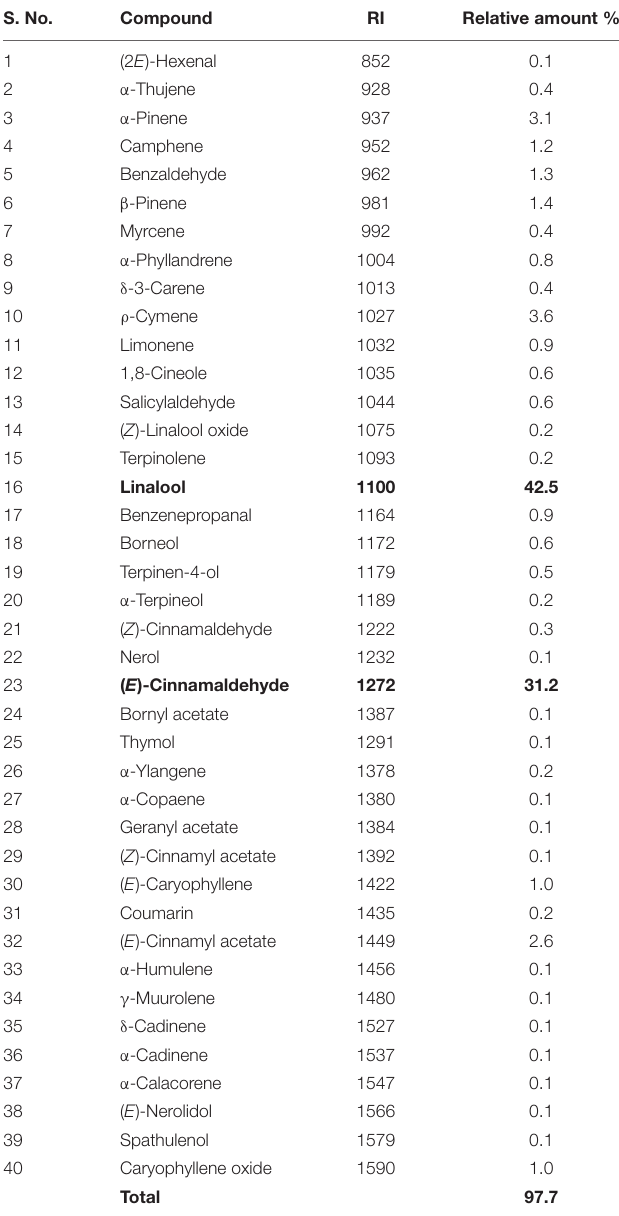
Bolded values indicate the compounds present in high percentage.